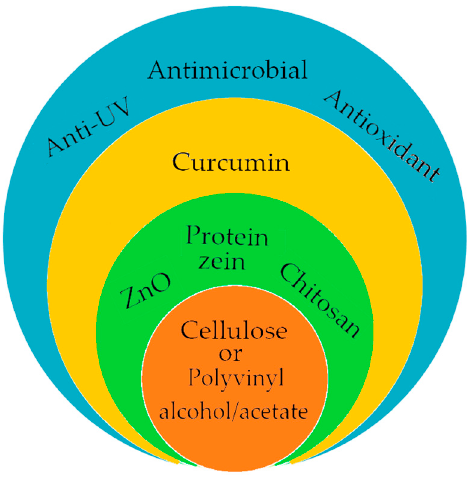
Figure 7. The main ingredients of active packaging.